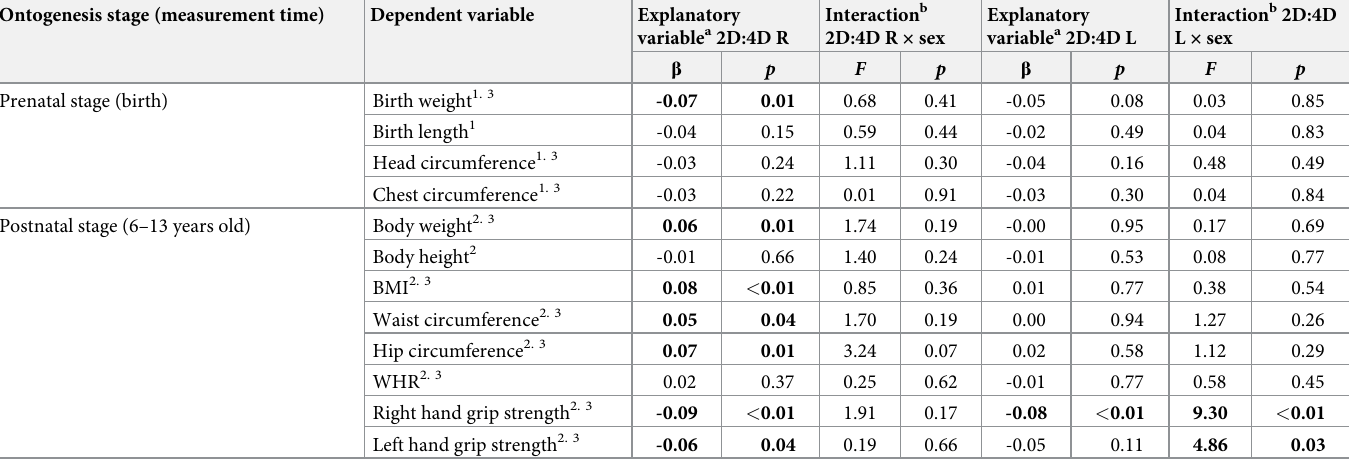
Table 4. Associations of right and left digit ratios (2D:4D R. 2D:4D L) and their interactions with sex with birth size parameters postnatal somatometric variables and grip strength of both hands. Ontogenesis stage (measurement time)